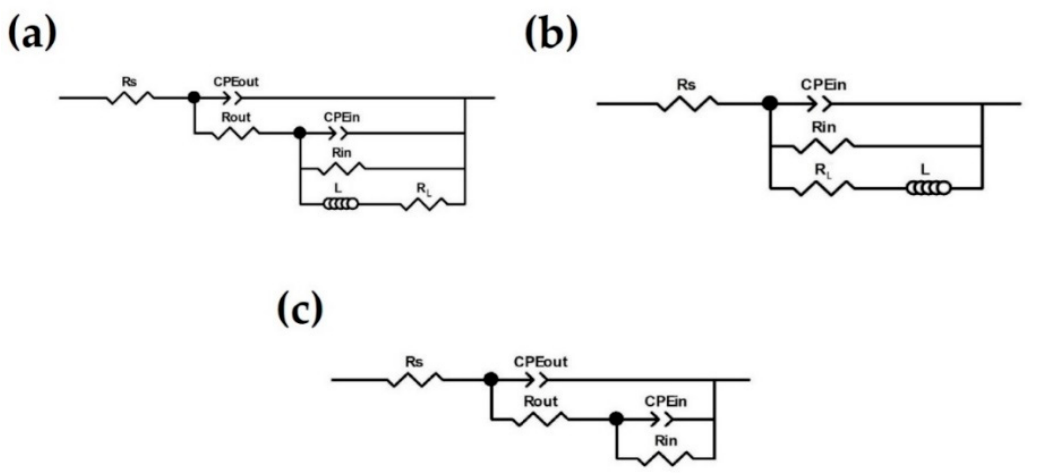
Figure 7. The equivalent electrical circuit (EC) models used to fit the EIS data; ( a ) double-layered coating with an induction loop, ( b ) single-layered coatings with an induction loop, and ( c ) double-layered coating. Table4. ElectricalelementsextractedfromEISdiagramsusingZviewsoftwareforAl, Ph, andSicoatings.